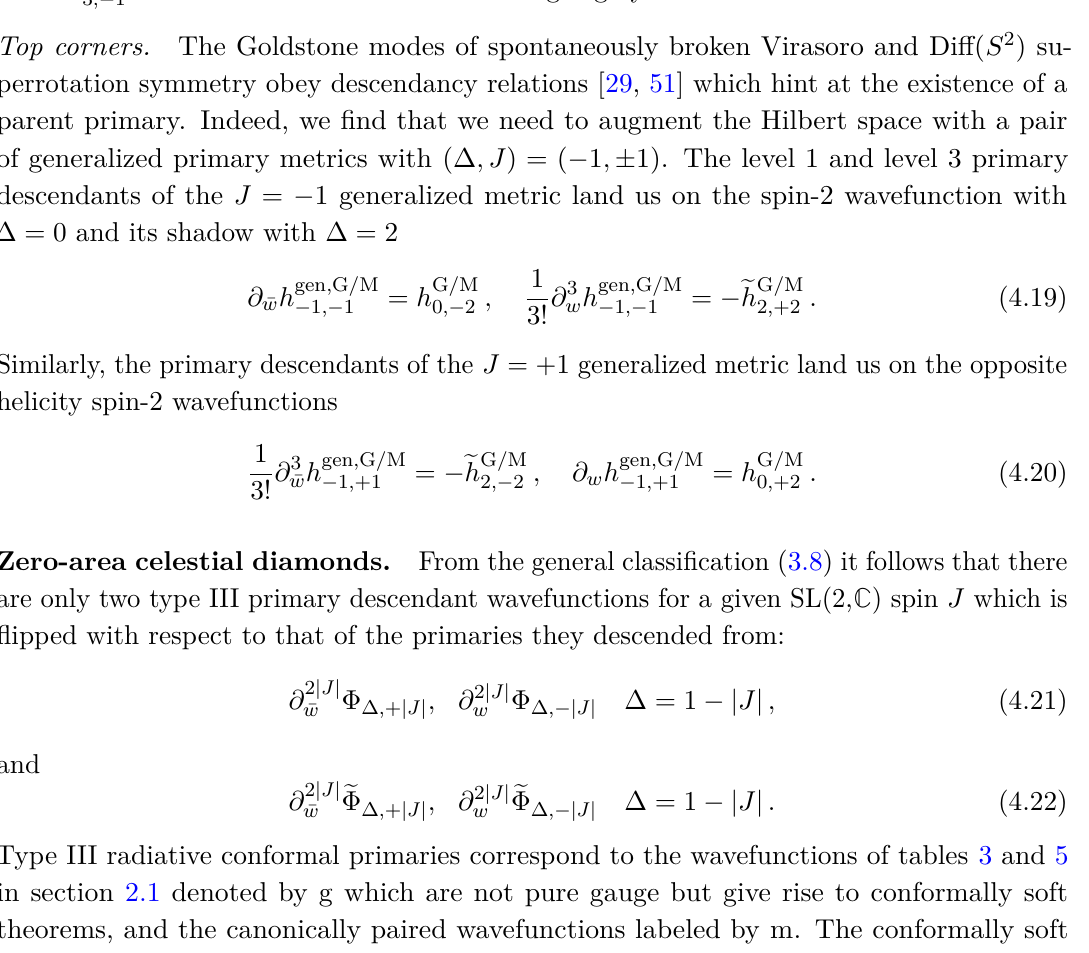
Figure 8. Goldstone (a) and memory (b) diamonds for the subleading soft graviton theorem. In figure 8 the generalized metric h gen , G / M fills the bottom corner of the dark grey diamonds, 3 , +1 while h gen , G / M fills the bottom corner of the light grey 3 , − 1